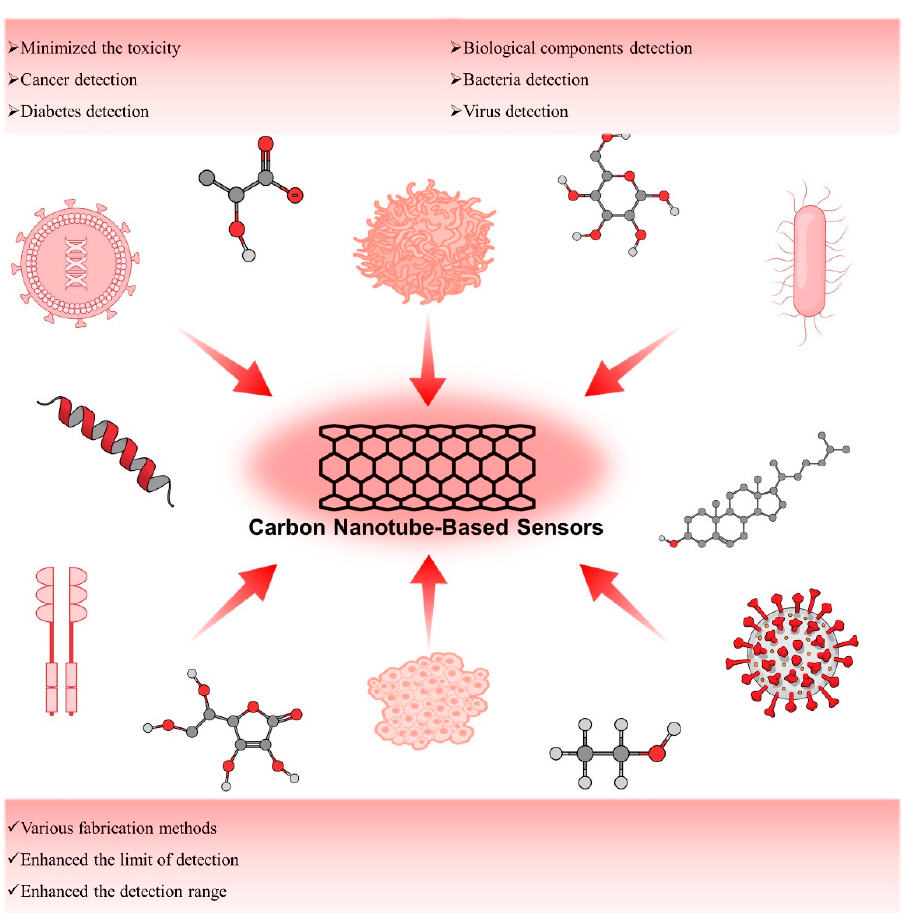
Figure 1. Schematic presentation of CNT-based biosensors.